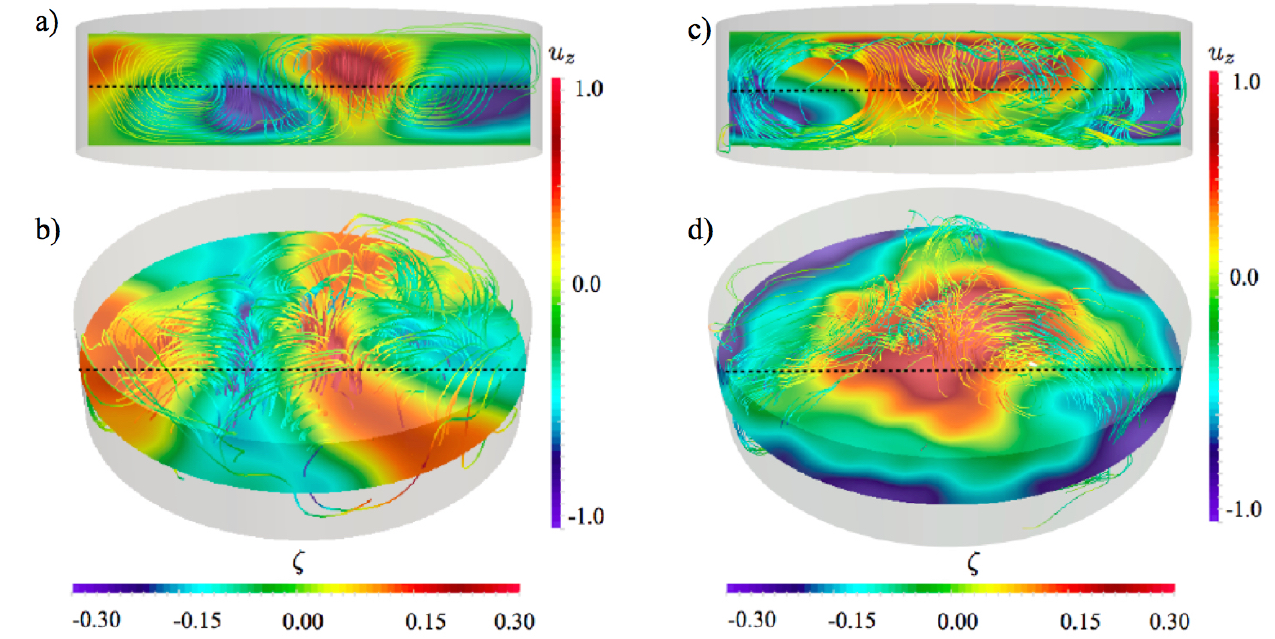
= 2 . 66 from cases Rayleigh-Be´nard convection Figure 7. Snapshot renderings at t/τ κ (RBC) 1 ( a , b ) and RBC 2 ( c , d ). Panels a and c show meridional slices of the thermal n n anomaly, ζ , with three-dimensional velocity streamlines color-coded with the local value of vertical velocity u . Panels b and d show oblique views of ζ on the mid-plane with velocity z streamlines